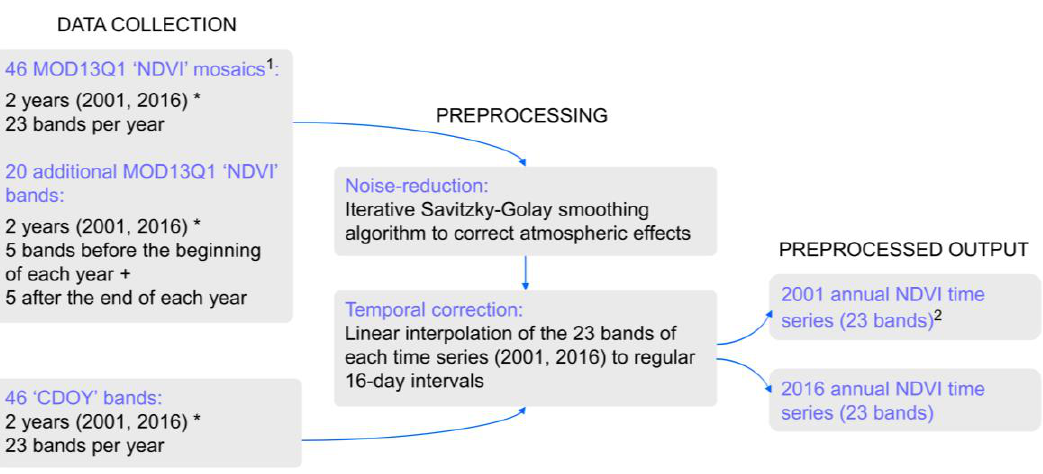
Figure 3. MODIS data collected and preprocessing steps. 1 The original data derives from 5 MODIS tiles h12v10, h12v11, h13v09, h13v10, h13v11, which have been cropped to the extent of the study areas and mosaicked to a single image mosaic per date (i.e., 23 mosaics per year). 2 The final annual time series start and end on the day-of-year 1 and 353, respectively.